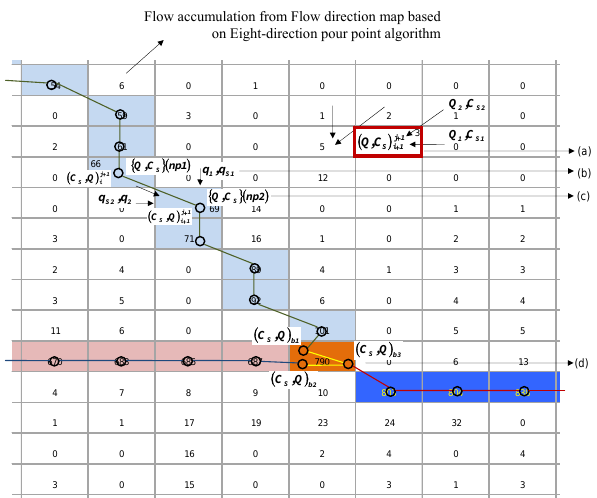
Fig. 4. Solution approaches for flow and sediment transport in distributed areas (description shown in Table 3).